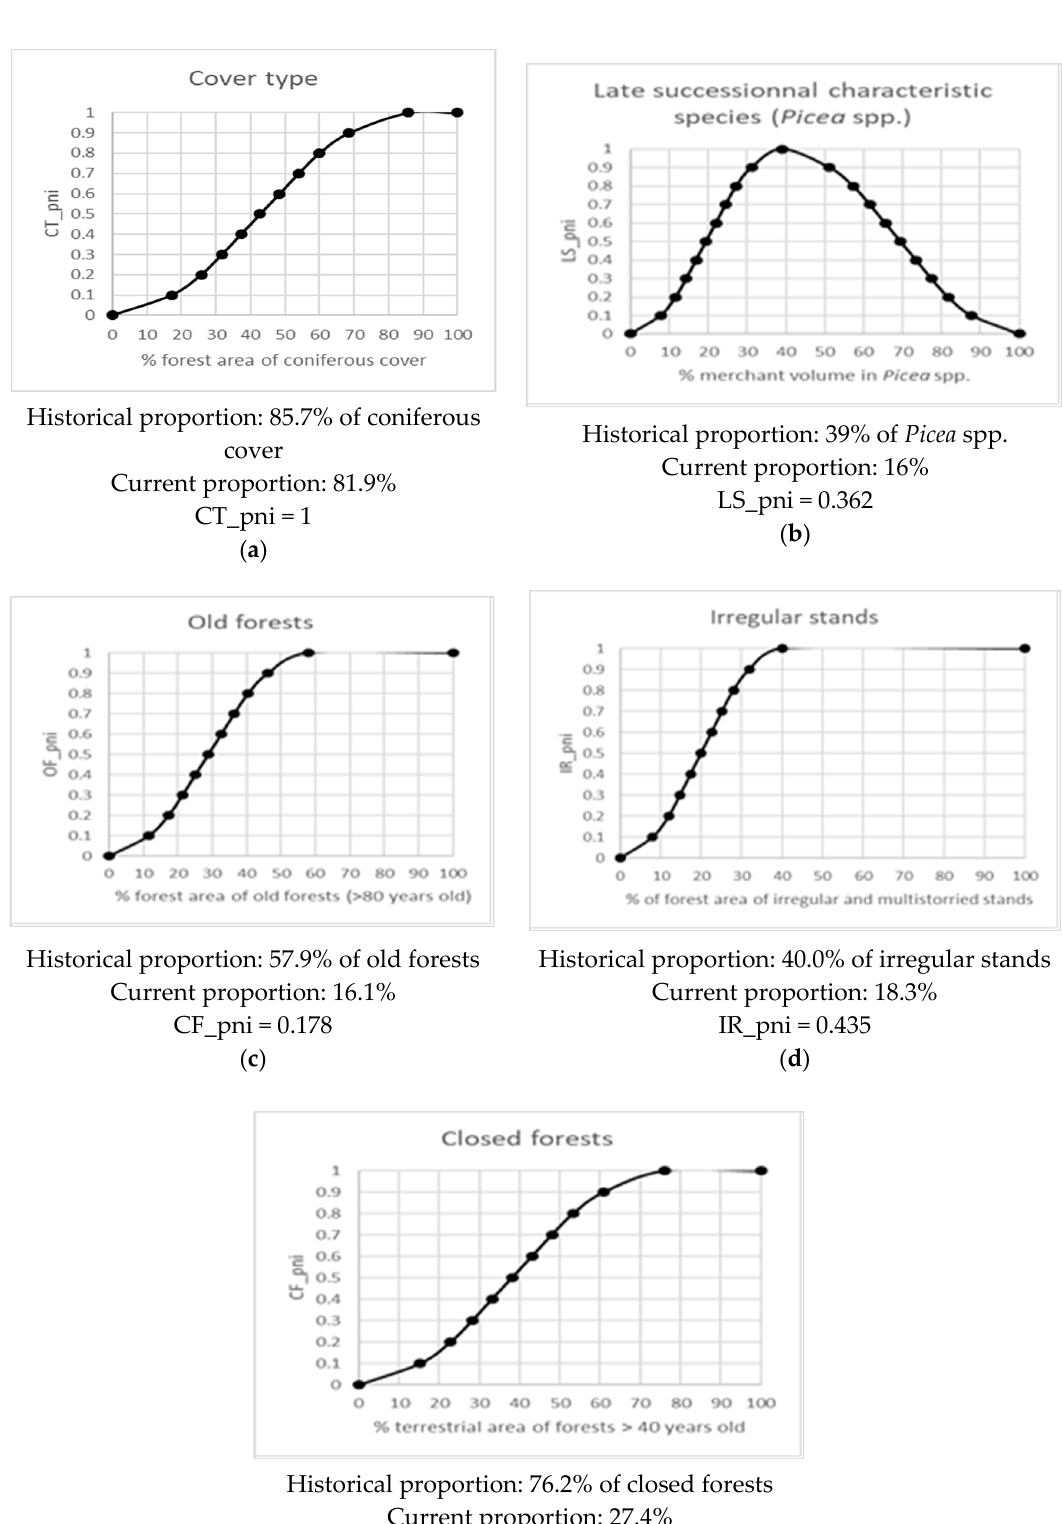
Historical proportion: 17.8% of irregular stands Current proportion: 14.2% IR_pni = 0.897 ( d ) Historical proportion: 79.9% of closed forests Current proportion: 39.1%